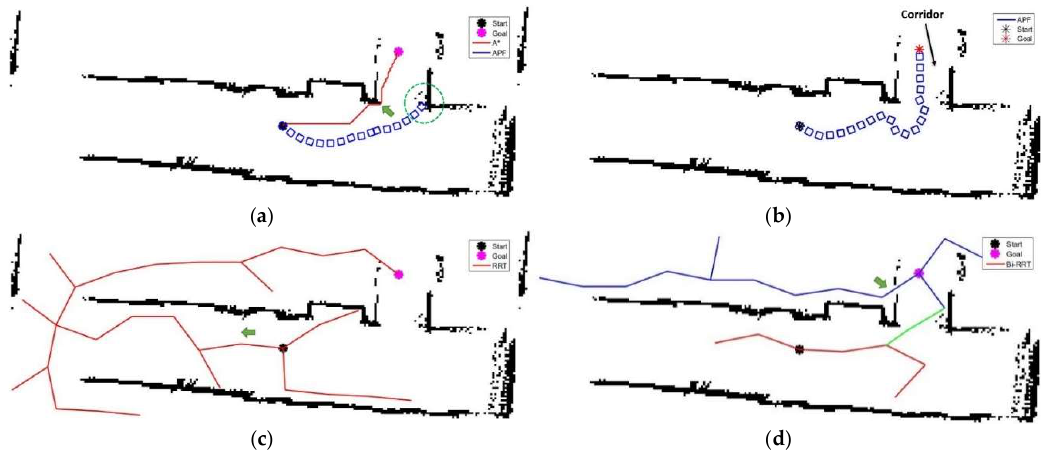
Figure 21. Generated path, for Dataset IV, using: ( a ) A* algorithm and APF method; ( b ) second iteration of APF method; ( c ) RRT algorithm; and ( d ) bidirectional RRT algorithm. of APF method; ( c ) RRT algorithm; and ( d ) bidirectional RRT